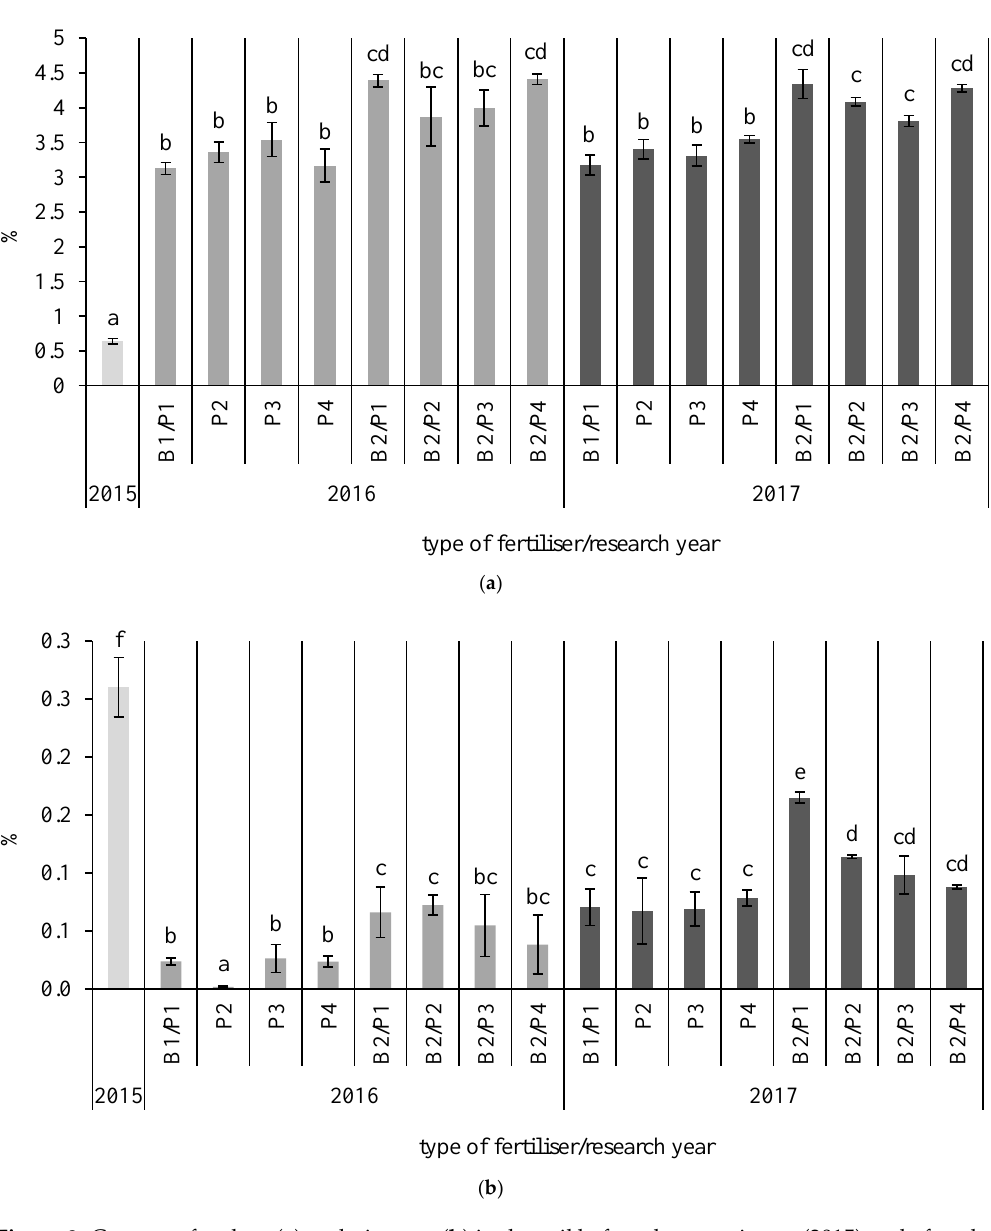
Figure 3. Content of carbon ( a ) and nitrogen ( b ) in the soil before the experiment (2015) and after the first and second year of cultivation, depending on the fertiliser used. Differences between average values marked with the same Arabic letters are not statistically significant at the level of α ≤ 0.05 according to the Bonferroni test.